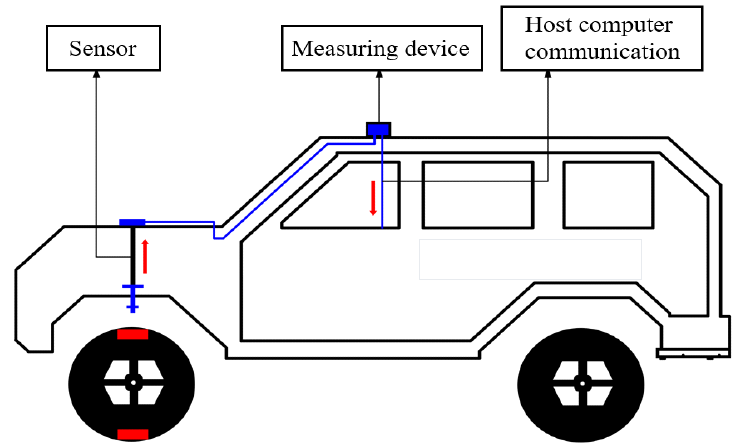
Figure 1. Schematic diagram of measuring device.